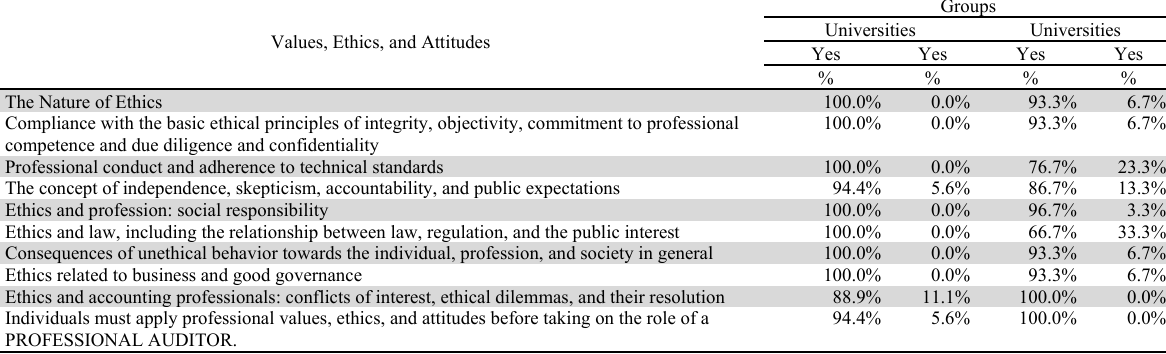
Values, Ethics, and